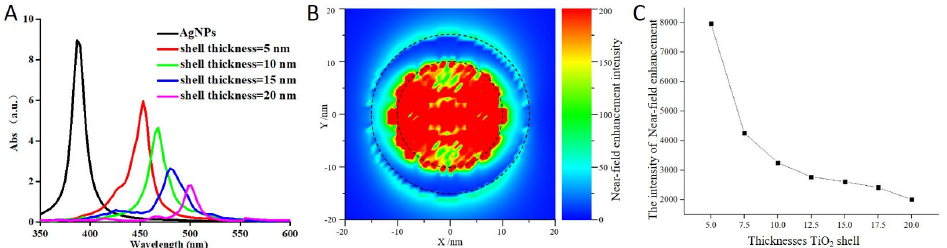
Figure 8. The simulated absorption spectrum ( A ) and the near ‐ field enhancement distribution ( B ) and enhancement intensity ( C ) of Ag ‐ core TiO 2 with the increasing thickness of the TiO 2 shell (from 5–20 nm). 5–20